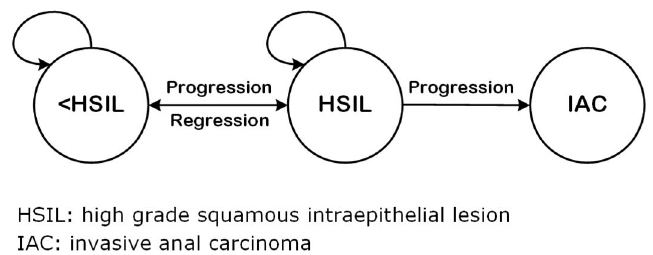
Figure 1. Three State Markov Model of Clinical Pathogenesis of Anal Neoplasia.